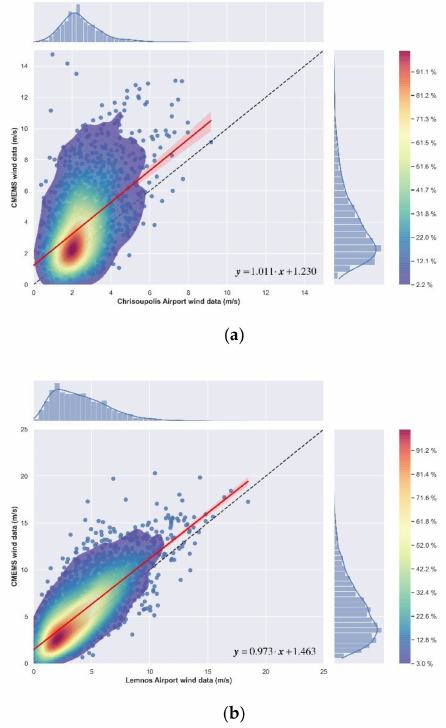
Figure 3. Density plots histograms of CMEMS wind speed data against wind data from on-site stations in ( a ) Chrisoupolis Airport and ( b ) Lemnos Airport. The dashed line represents the perfect match line, the red line the linear regression model fitted on the scattered data, and the light red area the 95% confidence